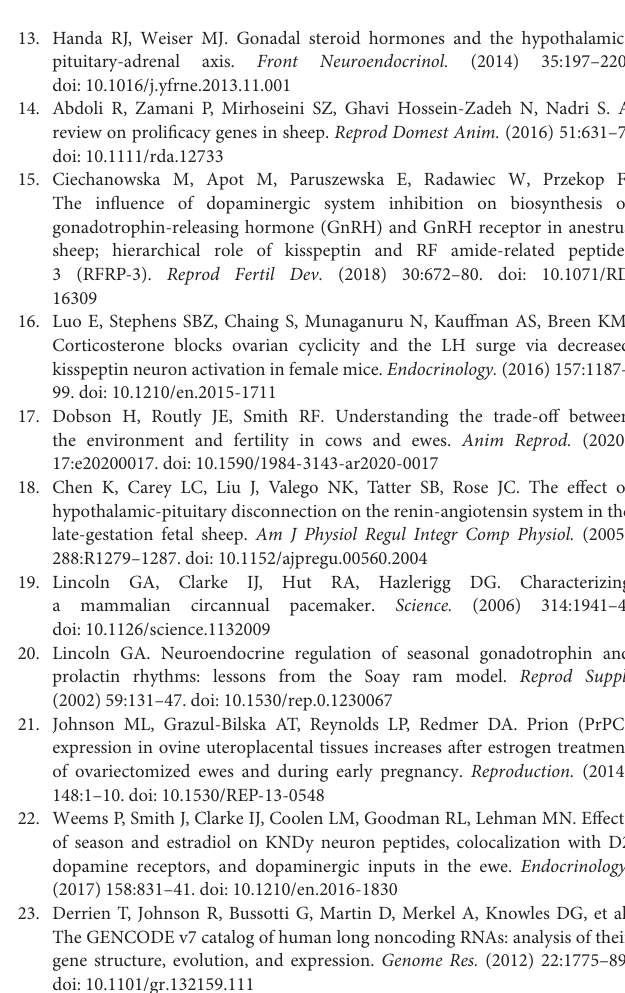
Supplementary Table 1 | The basic information of lncRNA sequencing data. Supplementary Table 2 | The FPKM values of both known and novel lncRNAs in SP42, LP42, and SP-LP42. Supplementary Table 3 | The information of lncRNAs and mRNA expressed in SP42 vs. LP42, SP42 vs. SP42-LP42 and LP42 vs. SP42-LP42. Supplementary Table 4 | GO enrichment annotation for target genes of lncRNAs at the MF, BP, and CC level in SP42 vs. LP42, SP42 vs. SP42-LP42 and LP42 vs.